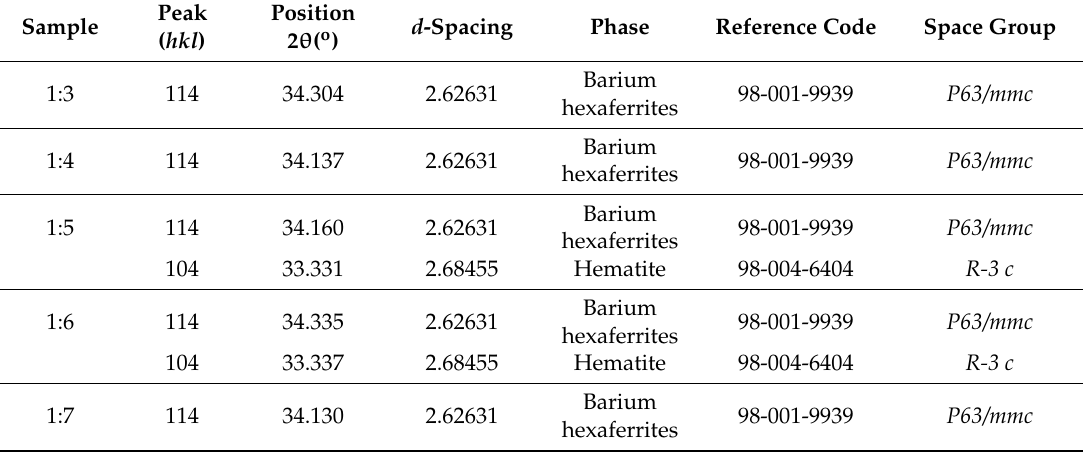
Table 1. X-ray diffraction parameters of the main peak (114), position, d -spacing, and height.